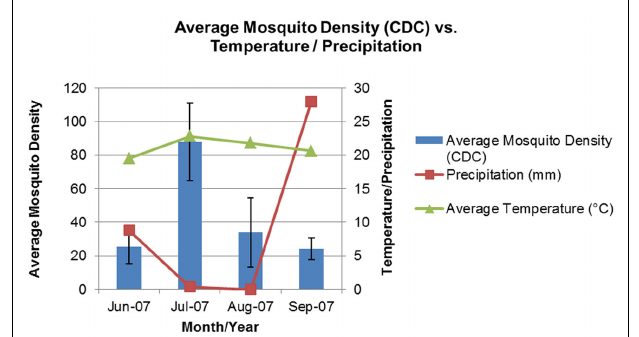
FIGURE 2 | Mean adult mosquito density collected by CDC traps, from June to September, 2007, in the seven surveyed lagoons, in coastal wetlands of